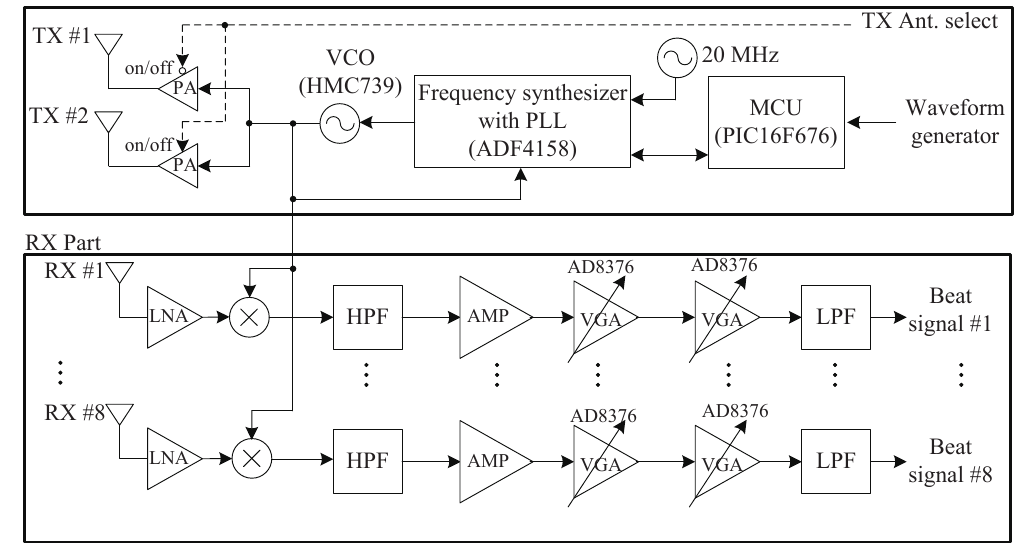
Figure 12. Block diagram of the 24 GHz radar radio frequency (RF) module.